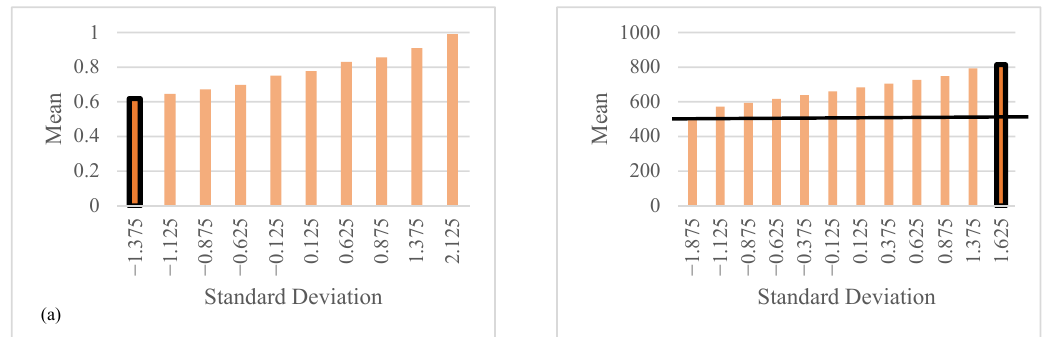
Figure 11. ( a ) Di ff erent states of relative compactness (X1); ( b ) di ff erent states of surface area Figure 11. ( a ) Different states of relative compactness (X1); ( b ) different states of surface area (X2).